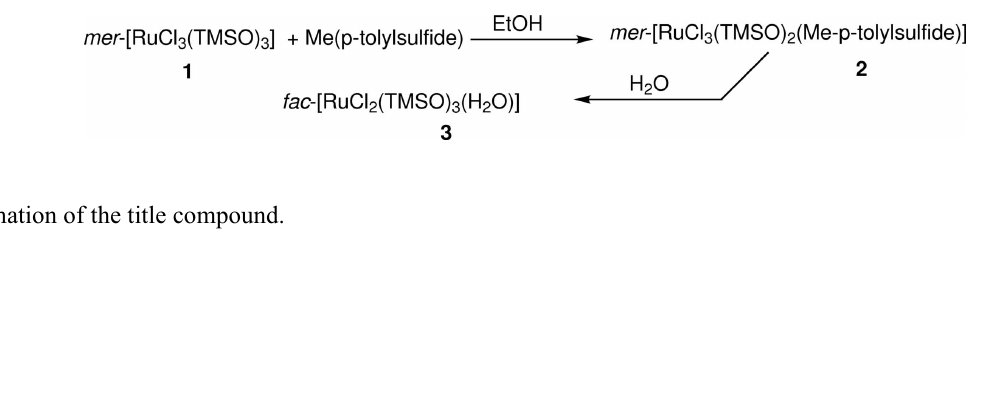
Figure 2 A portion of a hydrogen-bonded chain in the [010] direction.